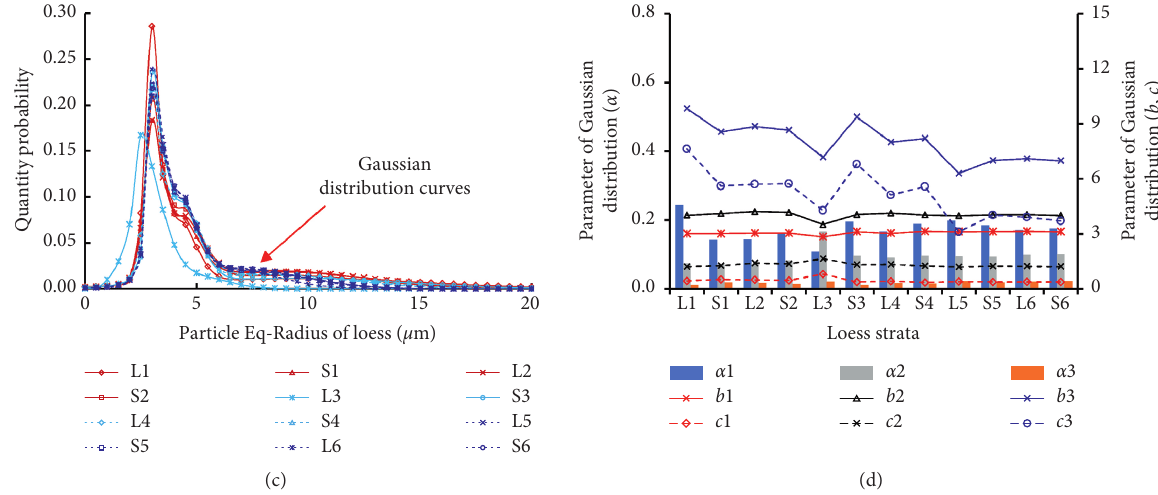
Figure 5: Distribution characteristics of Eq-Radius: (a) L1; (b) S1; (c) comparison of fitting curves of various layers; (d) variation in fitting